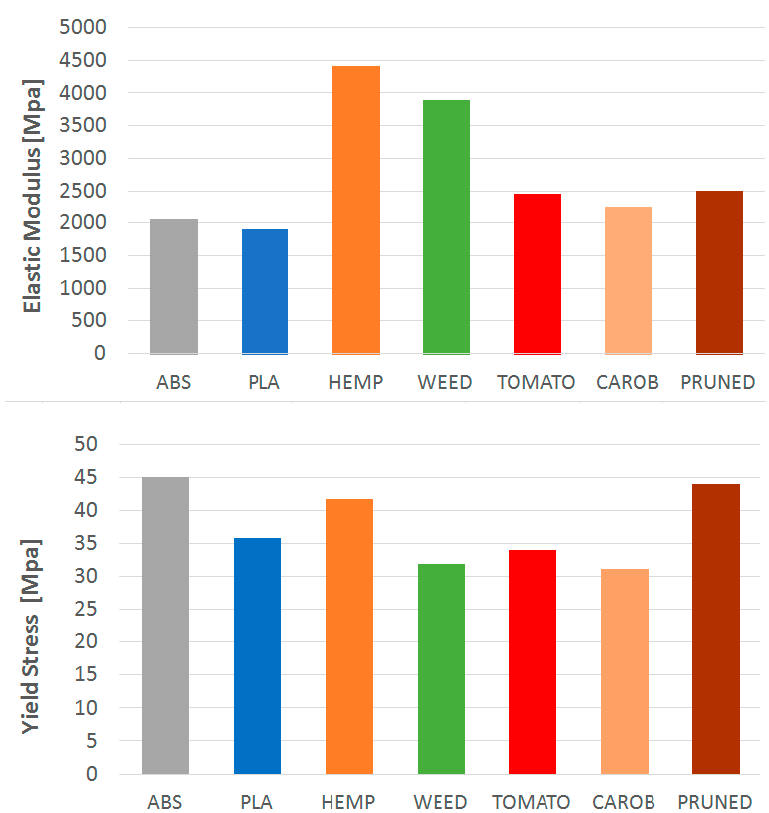
Figure 5. Elastic modulus (up) and Yield stress (down) for PLA and filled materials.